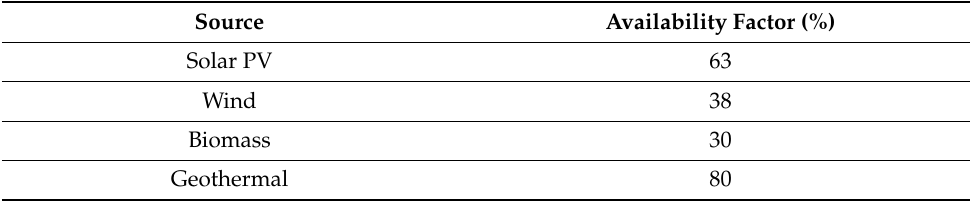
Table 2. Availability factor of Renewable Energy